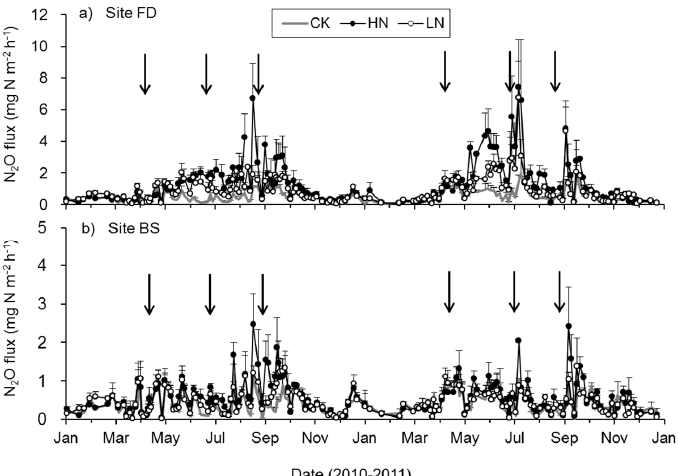
Figure 5. Seasonal variations in N 2 O flux across the sampling sites and treatments during 2010–2011. ( a ) Site FD, ( b ) Site BS. FD, fertilized ditch. BS, bare soil with none ferltilizers. Data points indicate the mean of the three replicates; error bars indicate the standard error (SE). Black arrows indicate nitrogen fertilizer applications.